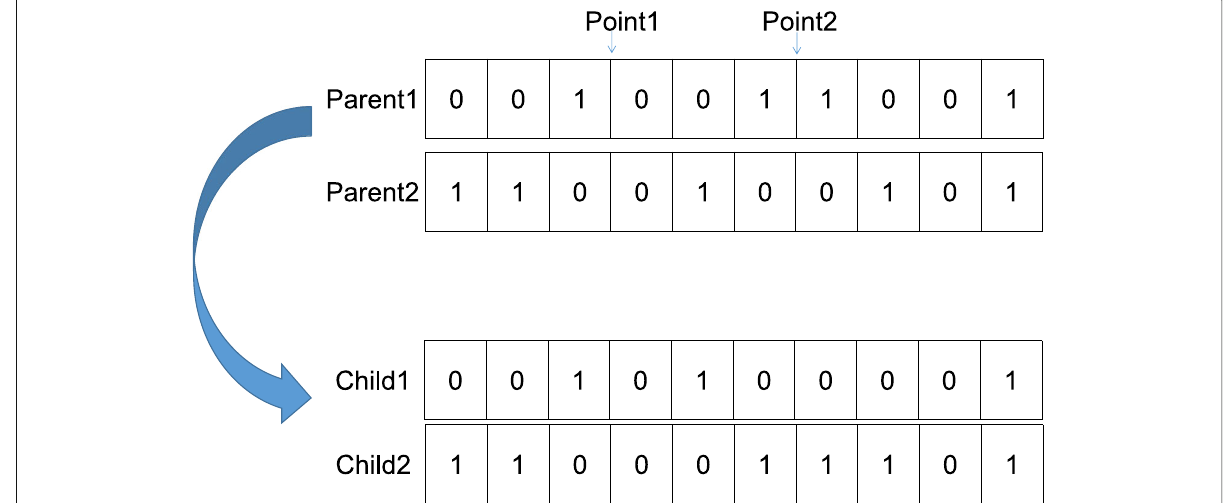
Fig. 3 Two-point